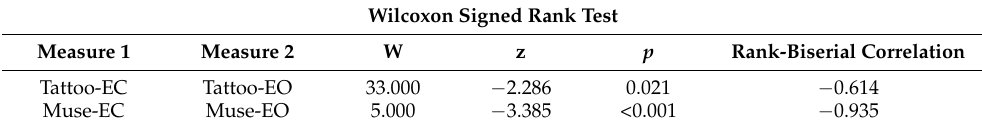
Table 2. Summaryandinferencestatisticsforthetwosystemswhencomparingthetwoexperimentalconditions.